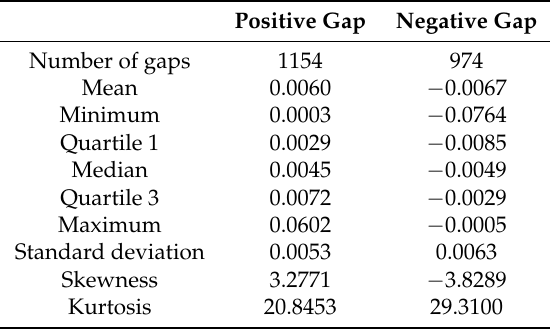
Table 1. Characteristics of positive and negative overnight gaps, which are identified by the Barndorff–Nielsen and Shephard (BNS) jump test, from January 1998–December